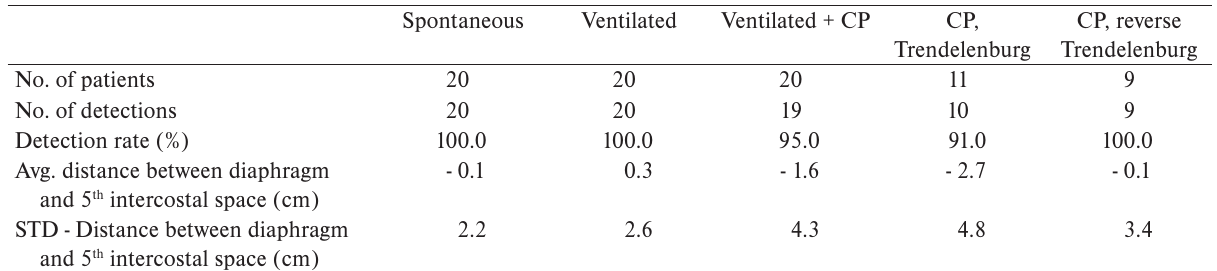
Table 3. The presence of the diaphragm in the region of EIT measurement (± 10 cm from the electrode belt plane at 5 th intercostal space) for spontaneously breathing patients (Spontaneous), for mechanically ventilated patients under general anesthesia with muscle relaxation (Ventilated) and for mechanically ventilated patients under general anesthesia with muscle relaxation and cap- noperitoneum (Ventilated + CP) divided into patients undergoing surgery in the Trendelenburg position (CP, Trendelenburg) and the reverse Trendelenburg position (CP, reverse